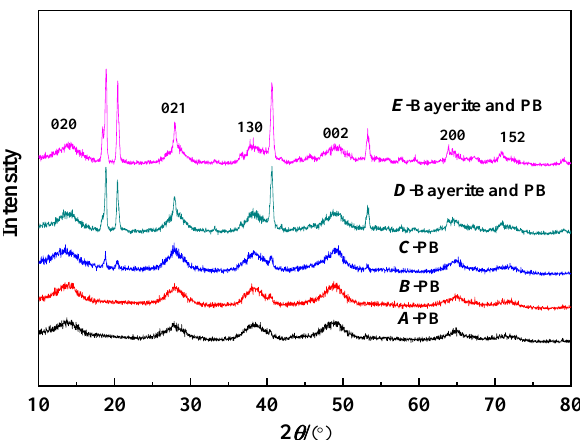
Figure 3. XRD results of PB with different concentrations of NaAlO 2 solution (gas – liquid ratio. 1:1; rotating speed of CF-RPB, 600 rpm).